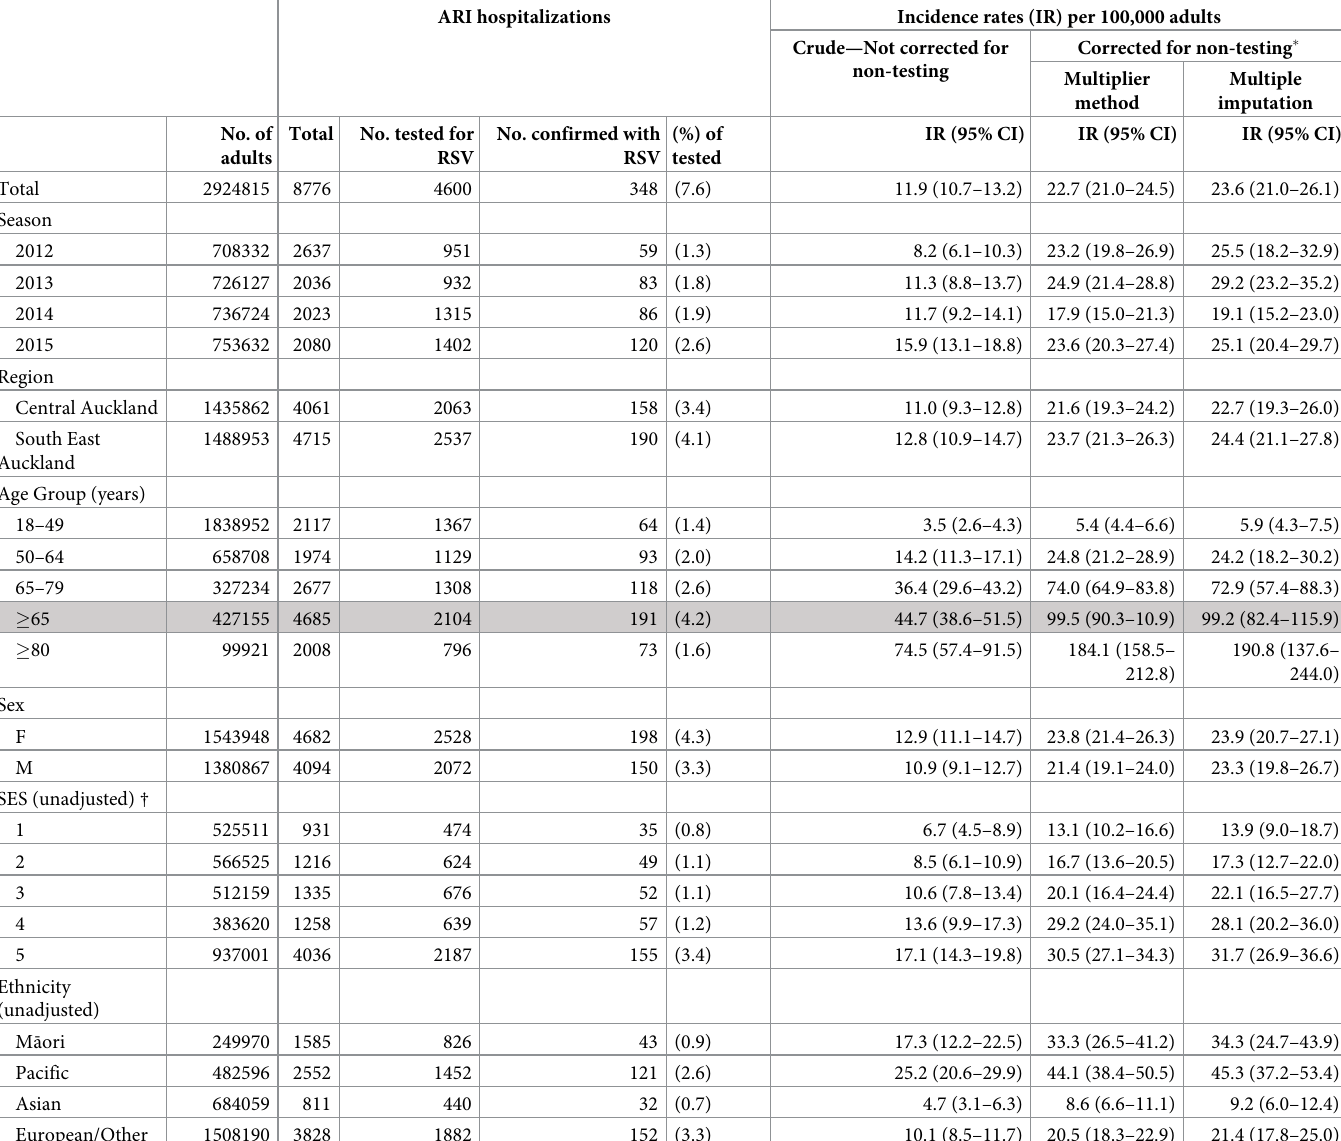
Table 1. Seasonal incidence rates (IR) of acute respiratory infection (ARI) and laboratory-confirmed respiratory syncytial virus (RSV)-associated ARI hospitaliza- tions among adults 18 years and older by year, Auckland sub-region, demographic factors in Auckland, New Zealand,